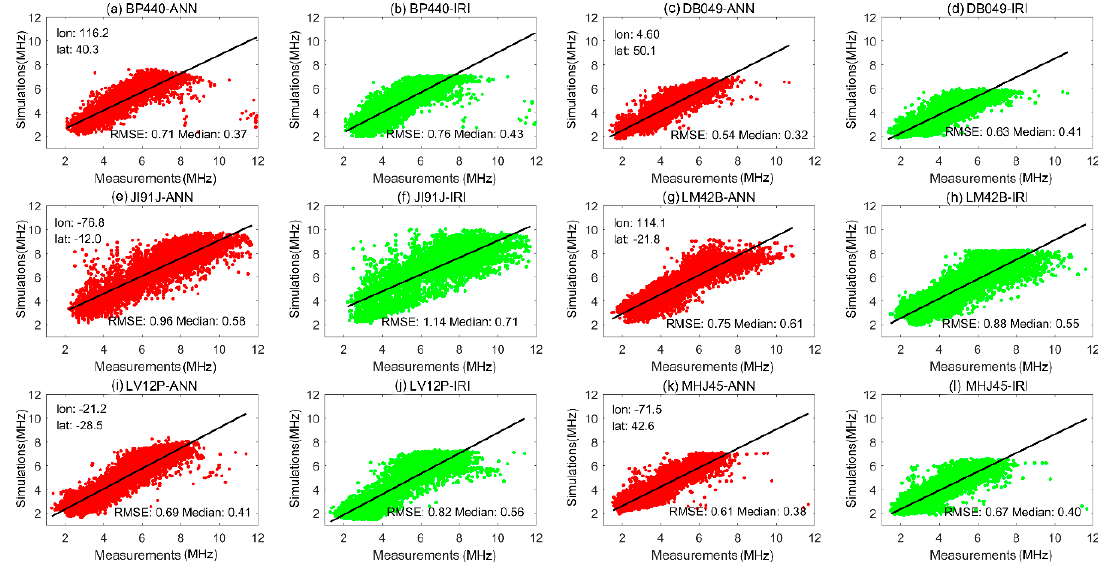
Figure 4. Various comparisons of the simulated accuracies between the Global Ionospheric Peak Frequency Model (GIPFM) and the International Reference Ionosphere (IRI)-2016 in 2009